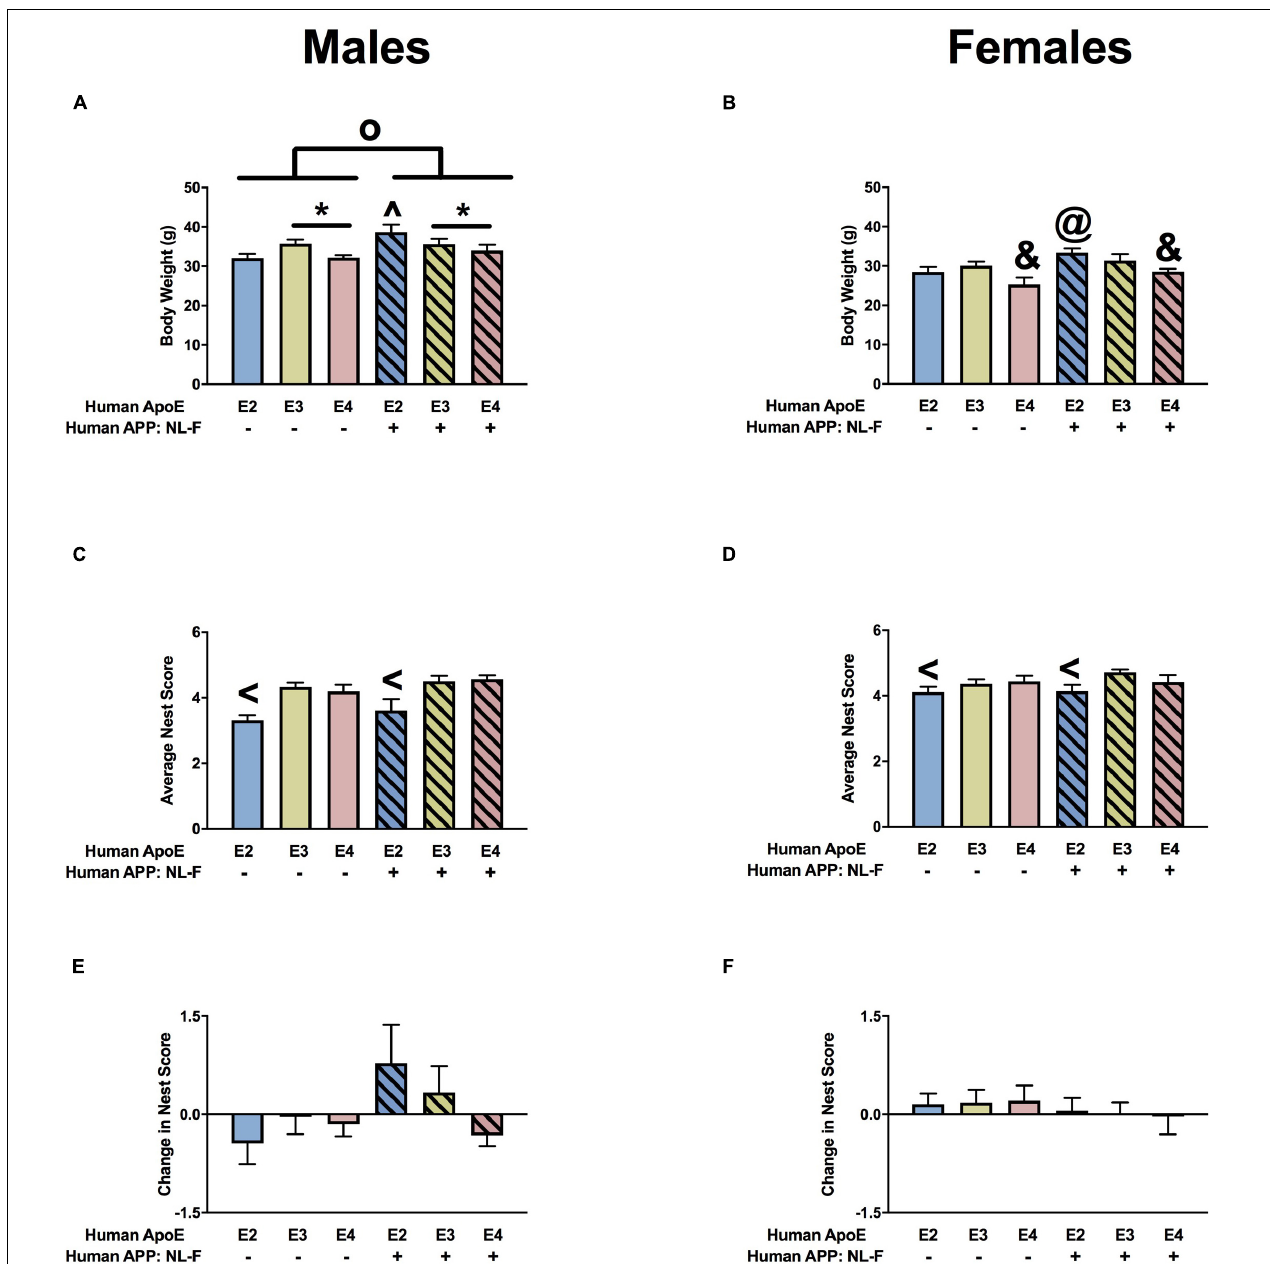
FIGURE 7 | Body weights and nest score measures in males (A,C,E) and females (B,D,F) at the 18-month time point. (A) There was an effect of APOE and APP on body weights of males. E3 males were heavier than E4 males. * p < 0.05. In addition, NL-F males were heavier. o p < 0.05. NL-F/E2 mice were heavier than NL-F/E3 and E2 mice. o p < 0.05. (B) There was an effect of APOE and APP on body weights of females. E4 females were lighter than E2 and E3 females. & p < 0.05. NL-F-E2 females were heavier than E2 females. @ p < 0.05. (C) There was an effect of APOE on nest scores of males. E2 males had lower nest scores than E3 and E4 males. < p < 0.05. (D) There was a trend toward an effect of APOE on nest scores of females. E2 females had lower nest scores of E3 females. < p < 0.05. (E) Change in nest score of males. (F) Change in nest scores of females.